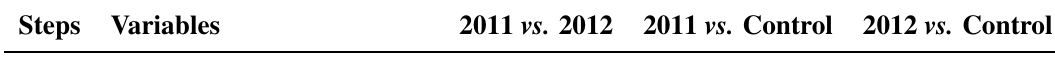
Table 1. Significance levels of the pairwise group comparisons between the three sites (2011 Nest, 2012 Nest and Control Site) used by Socotra Cormorants in the UAE for both discriminant steps: step 1 (percent droppings included) and step 2 (percent droppings and